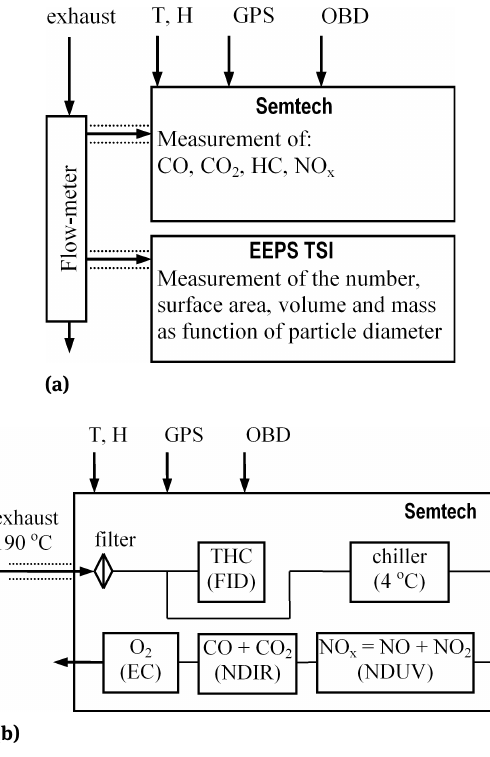
Figure 1: Diagram of the measurement system used for testing